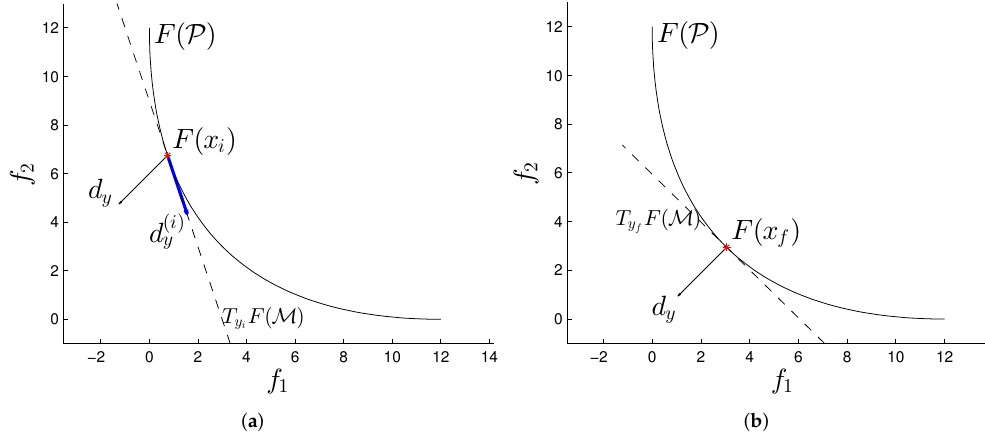
( i ) Figure 2. ( a ) d y is the orthogonal projection of d y onto the linearized Pareto front at F the best fit direction for a movement along the Pareto front. ( b ) The process has to be stopped at x f if T y F ( M ) and d y are orthogonal to each f